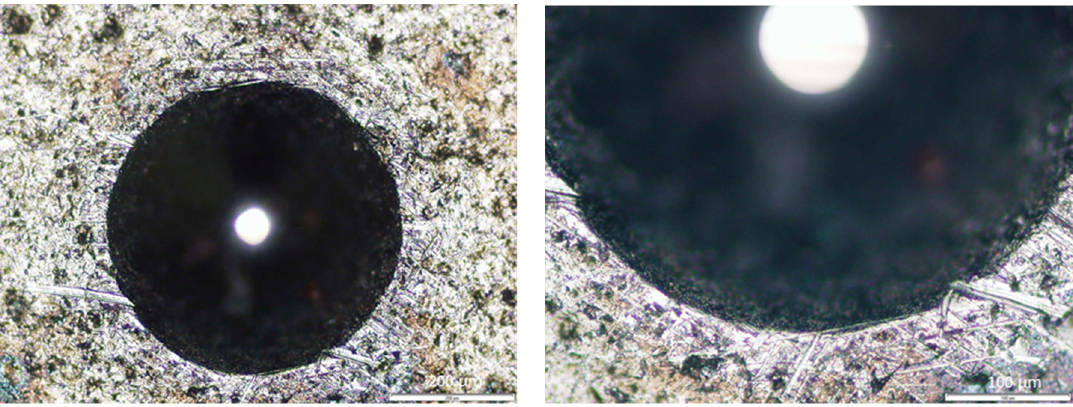
Figure 9. SEM image of one of the three TiAlN coating scratches produced during the scratch tests.